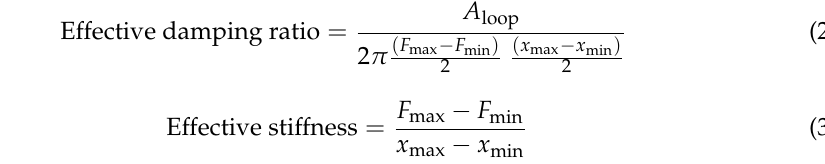
The cyclic loading tests were carried out to investigate how the WRIs act